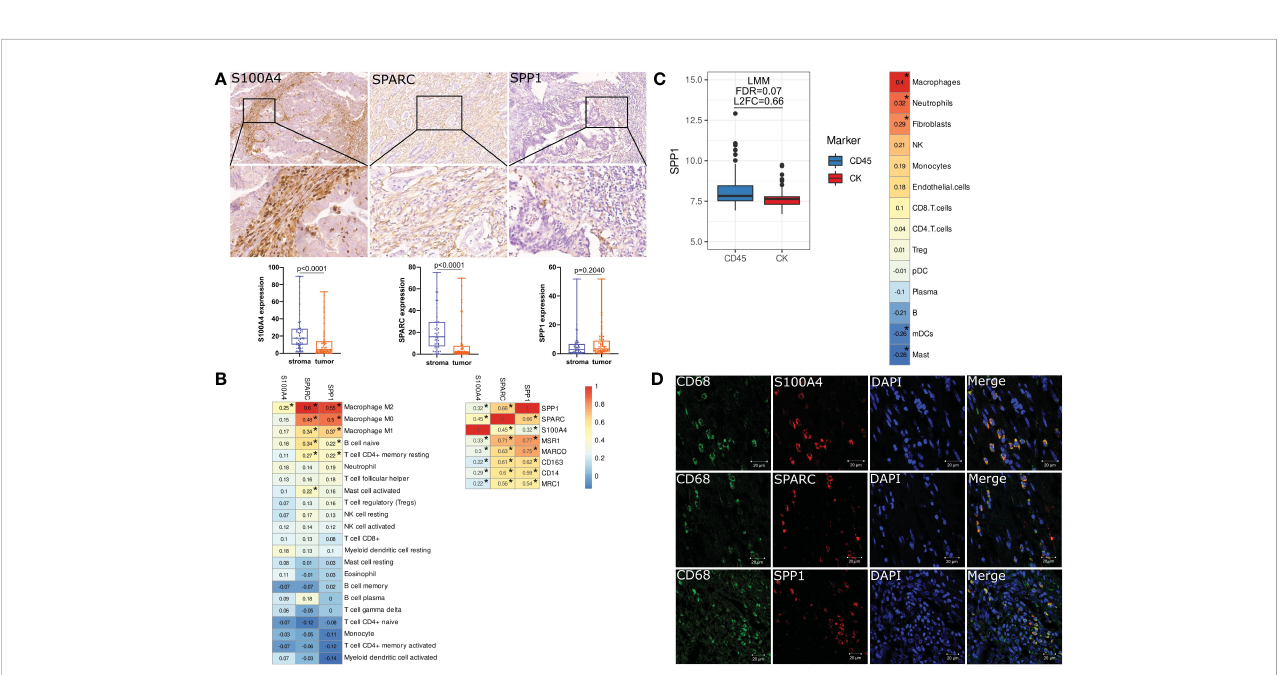
FIGURE 4 S100A4, SPARC and SPP1 are expressed by tumor-associated macrophages in colorectal cancer. (A) IHC representative images (x400) of stromal S100A4, SPARC and SPP1 in tumor tissue. Zoom images is given in the lower panel (x800). Stromal expression of S100A4 and SPARC is higher than tumor expression. The protein level of SPP1 does not have differences between tumor and stroma. Student ’ s t-test was applied. (B) Immune cell-type deconvolution analysis that was performed via the TIMER2.0 web platform using the CIBERSORT method. S100A4, SPP1 and SPARC gene expression correlates with macrophages. *: |rho|>0.2 and FDR<0.05. (C) Nanostring GeoMX DSP revealed increased expression of SPP1 in the immune compartment and its correlation with macrophages. *: |rho|>0.2 and FDR<0.05. (D) Confocal microscopy con fi rmed the co-localization of S100A4, SPARC and SPP1 in CD68+ TAMs. Scale bars equal 20 µm.